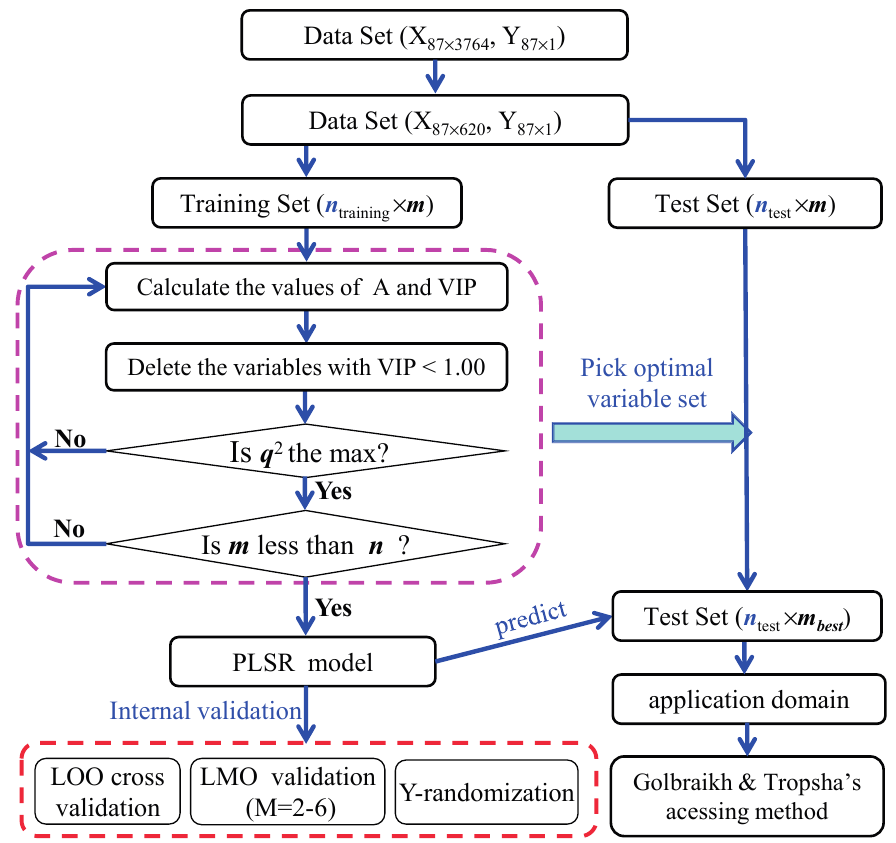
Figure 3. Sketch map for modeling and validation process of the CI